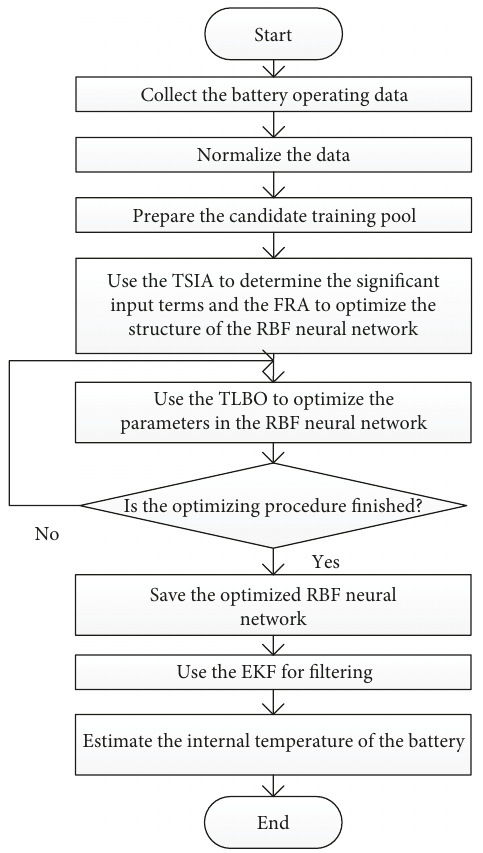
Figure 4: The overall fl ow diagram of the proposed TSIA-based RBF NN internal temperature